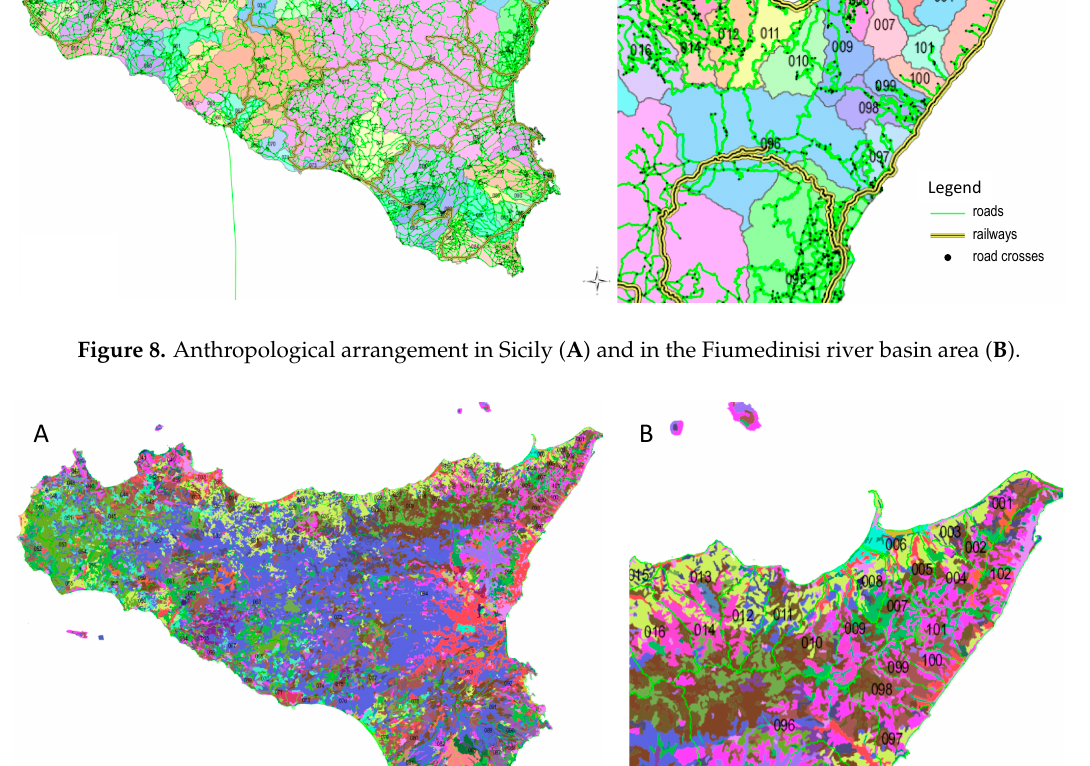
Figure 9. Land uses in Sicily ( A ) and in the Fiumedinisi river basin area ( B ).